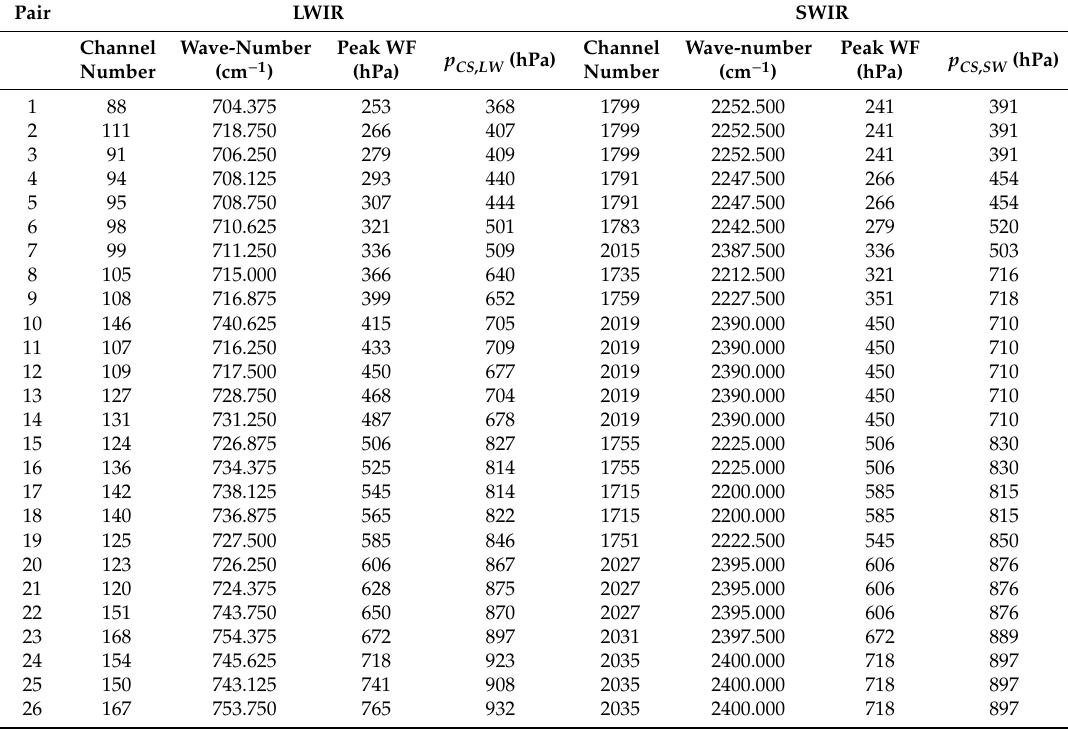
Table 3. Channel number, wavenumber, WF peak and cloud-sensitive level ( p CS ) for the final paired 26 LWIR an SWIR HIRAS channels using the modified method in this